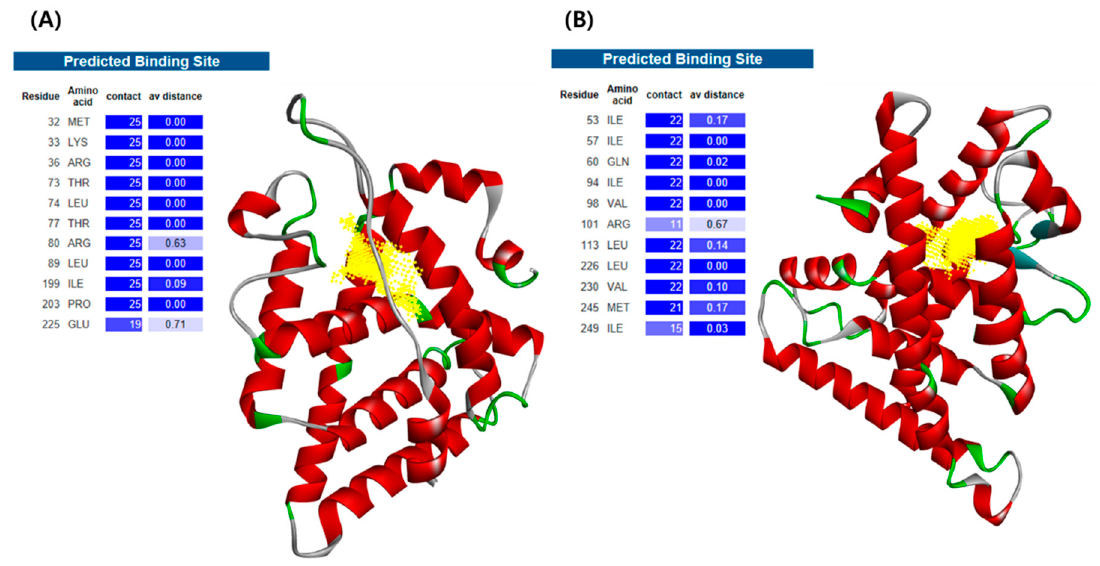
Figure 1. The 3D structure of C. elegans receptors, ( A ) NHR-14 and ( B ) NHR-69 predicted by Protein Homology/analogY Recognition Engine V2.0 (PHYRE2) server, and their protein ligand binding residues predicted by 3DLigandSite. The homology model was colored according to the secondary structure, and the ligand binding site was displayed in yellow.